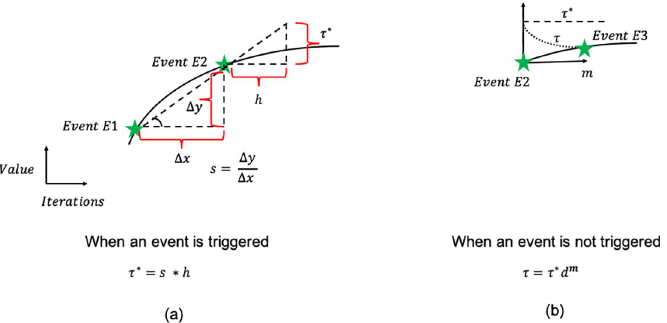
Fig 4. Procedure for calculation of the threshold of event-triggered communication at the sending PE. When the event E2 is triggered, a new threshold τ � is calculated by multiplying the local slope s between events E1 and E2 with the horizon h as shown in the left subfigure (a). Then the previously calculated threshold τ � is gradually decayed in the form τ = τ � d m where 0 < d < 1 is the decay rate and m is the number of iterations since the event E2 when τ � was calculated. This decay phenomenon, shown in subfigure (b), continues until the next event E3